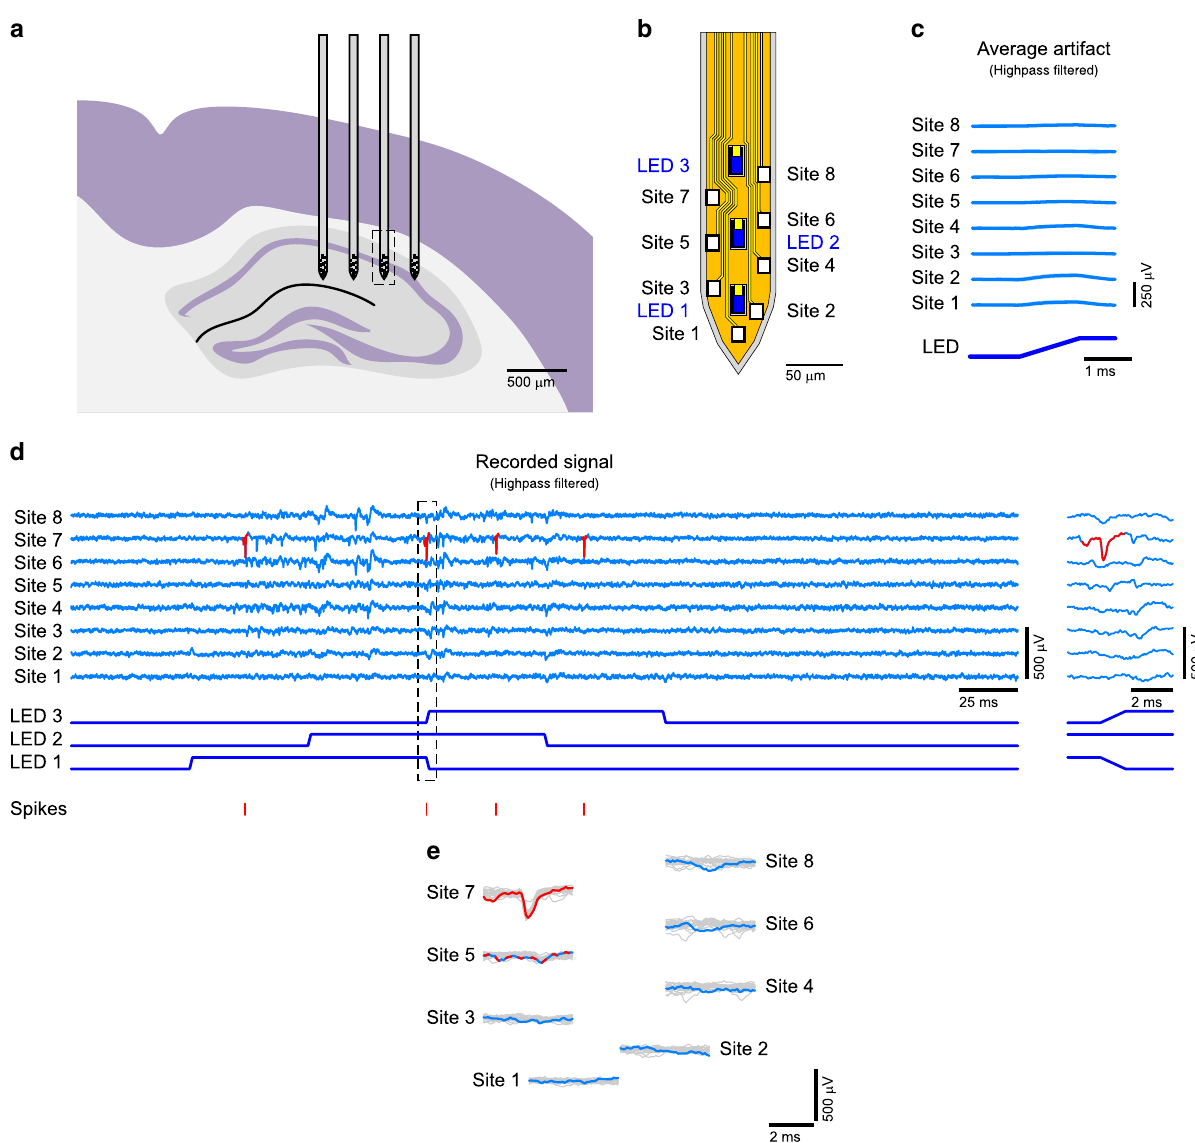
Fig. 6 Stimulation-artifact-free in vivo opto-electrophysiology. a Schematic illustration of the location of implanted miniSTAR μ LED optoelectrode inside the brain. The shank from which the data presented in parts c – h were collected is highlighted with a rectangle with dashed lines. b Schematic illustration of the tip of the miniSTAR optoelectrode. c Mean waveforms of stimulation artifact recorded on miniSTAR optoelectrodes, from channels that correspond to the electrodes on different locations on the tips. Shaded regions show one standard deviation away from the mean. LED drive signal with resulting LED surface irradiance of 3 mW mm – 2 at the surface of the LED (radiant fl ux of 460 nW) was used. One LED was turned on and off at a time. d Traces of the recorded signals and the raster plots of sorted spikes. No signal processing, except for highpass fi ltering, was applied to the recorded signal. The inset on the right shows the magni fi ed view of the region inside the rectangle with black dashed lines. e Magni fi ed waveforms of the spikes recorded during the period highlighted in part d , overlaid on top of waveforms of 20 other spikes from the same neurons. Both spontaneous and light-induced spike waveforms are used without